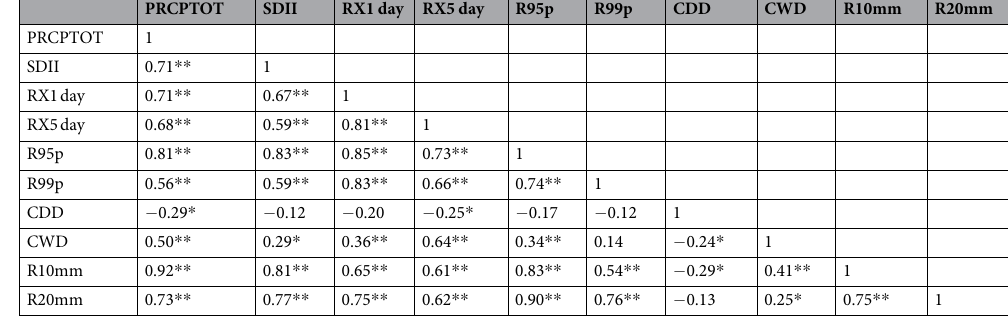
Table 3. Correlation coefficients of extreme precipitation indices in the Qilian Mountains. For description of index names, see Supplementary Table S1. * and ** represent significance at the 0.05 and 0.01 level,